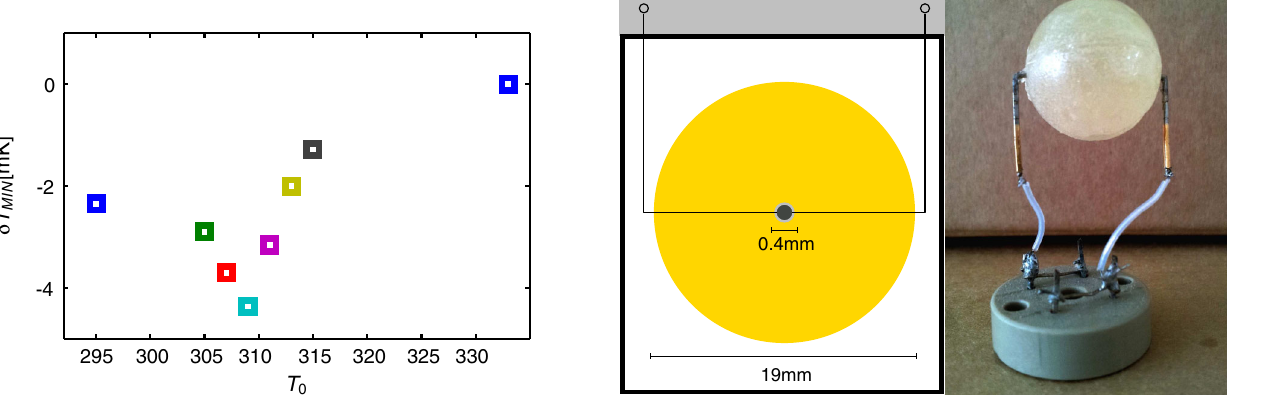
FIG. 11. Sketch of the experimental setup. The liquid is molded into a sphere, in which a small NTC-thermistor bead is placed at the center, connected to wires that lead to a multimeter that performs resistance measurements. The sphere is inserted into the cylindrical chamber of a cryostat. The photo shows one of the samples; at the time of the photo shoot (1 month after molding) the sample is no longer transparent because it crystallized.